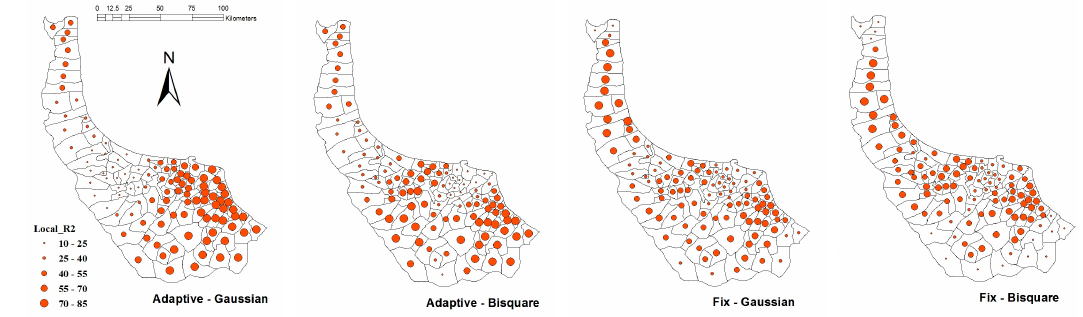
Figure 6. Local R 2 (%) of GWR model using AIC.